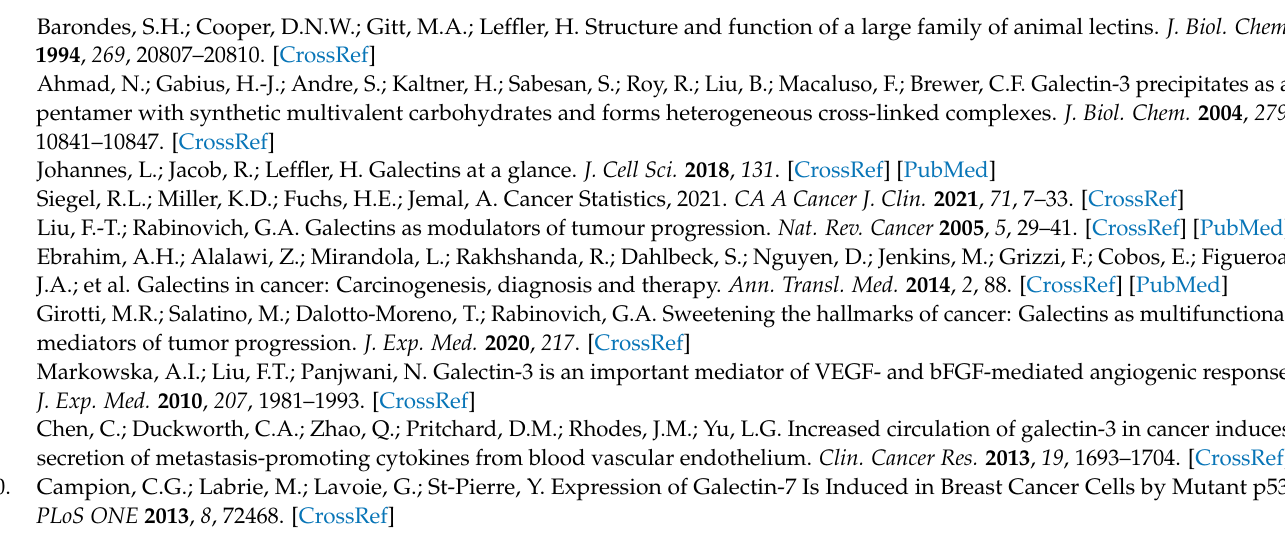
patient demographics, Table S3: Colon cancer patient demographics, Table S4: Galectin concentration values for patient groups in Figure 1, Table S5: Galectin concentration values for patient groups in Figure